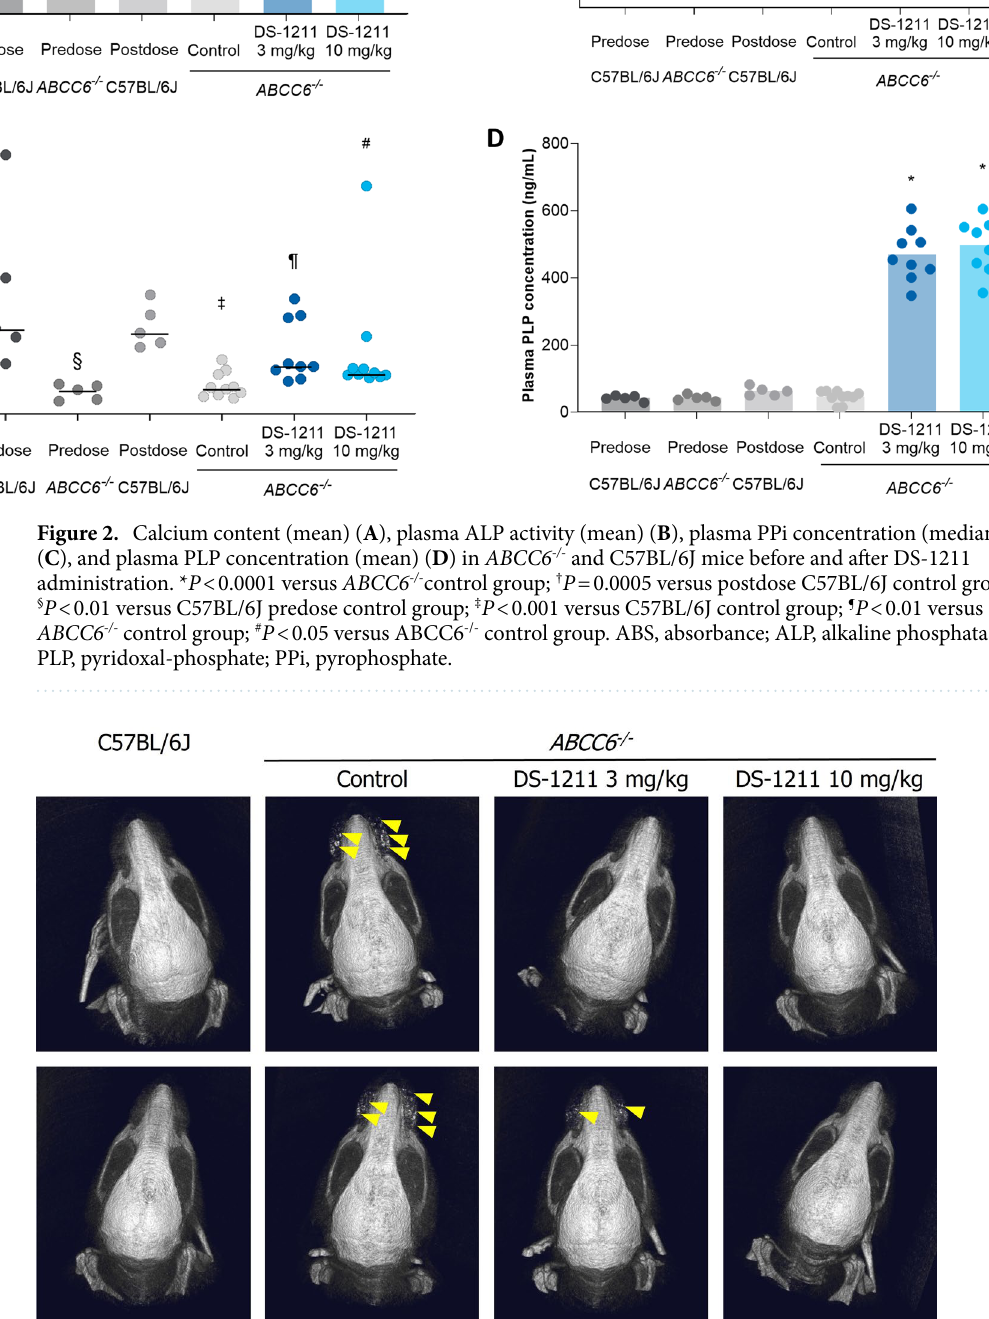
Figure 3. Microcomputed tomography imaging showing calcification of vibrissae in C57BL/6J and ABCC6 -/- control groups and ABCC6 -/- DS-1211 3 mg/kg and DS-1211 10 mg/kg treatment groups after dosing. Representative images from two mice in each group are shown. Yellow arrows indicate calcium